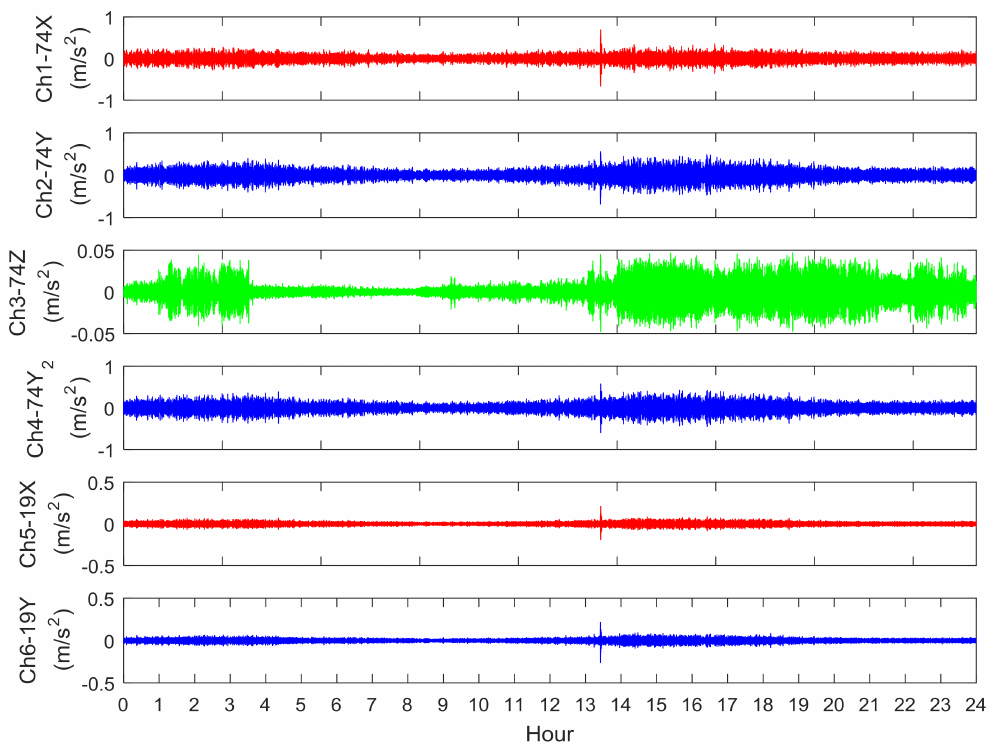
Figure 4. Time-series of acceleration data on 31 May